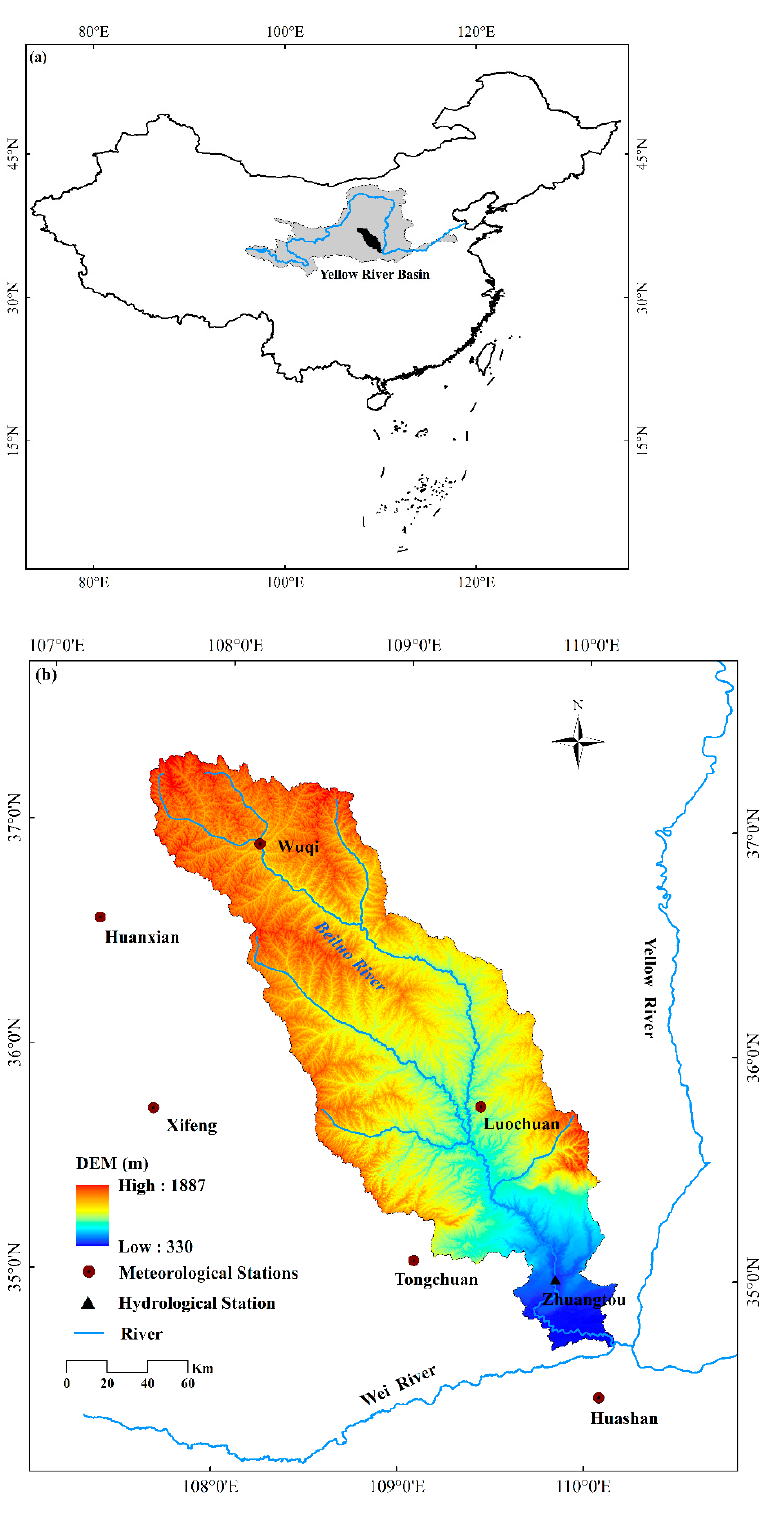
Figure 1. ( a ) Location of the study region in the Yellow River Basin; ( b ) Hydrological and meteoro- logical stations in the Beiluo River Basin.